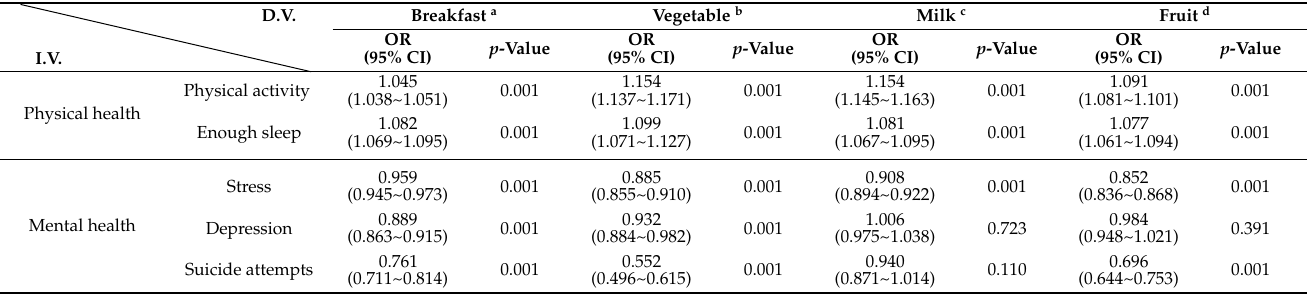
Table 8. Odds ratios for dietary intake according to physical and mental